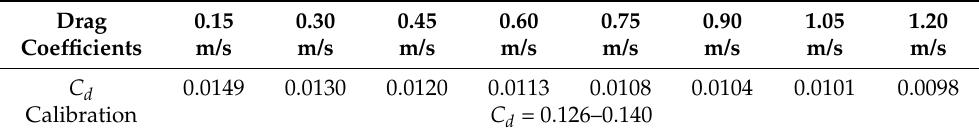
Figure 7. Power of crucian carp at different swimming speeds. The value of P s (black solid line) was obtained using Equation (9). P d (blue dotted line) were fitted using Equation P d = k U s 3 using oxygen consumption rate data for swimming speeds not greater than 0.45 m/s ( P s = 0.9 P d , P s = 1.718 U s 3 , R 2 = 0.953; P s = 1.0 P d , P s = 1.910 U s 3 , R 2 = 0.954). Table 2. Drag coefficients at various water